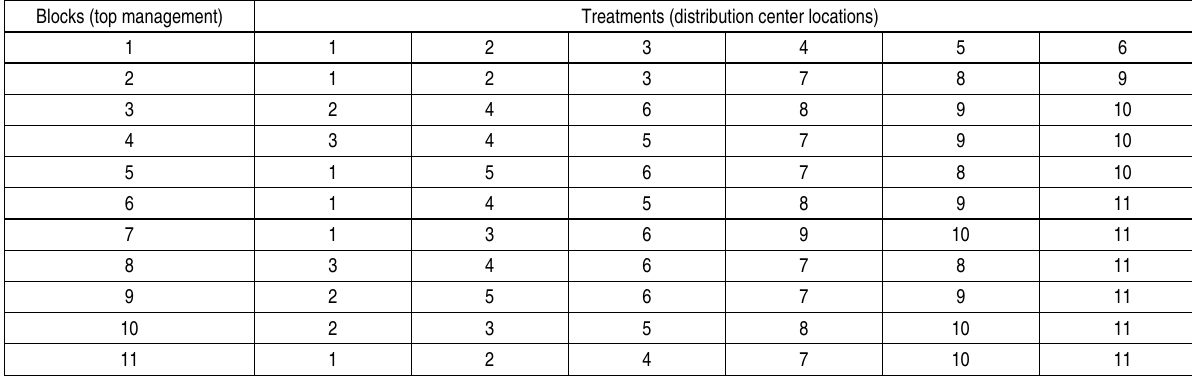
Table 7. General BIBD for ranking of distribution center locations Blocks (top management)